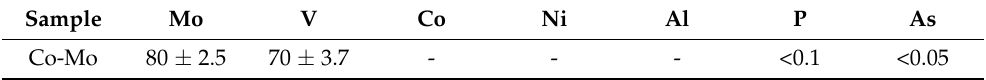
Table 3. Leaching of metals (%).